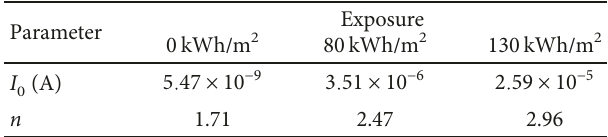
and I of a 36-cell module oc sc and n 0 - I method. oc sc - I oc sc